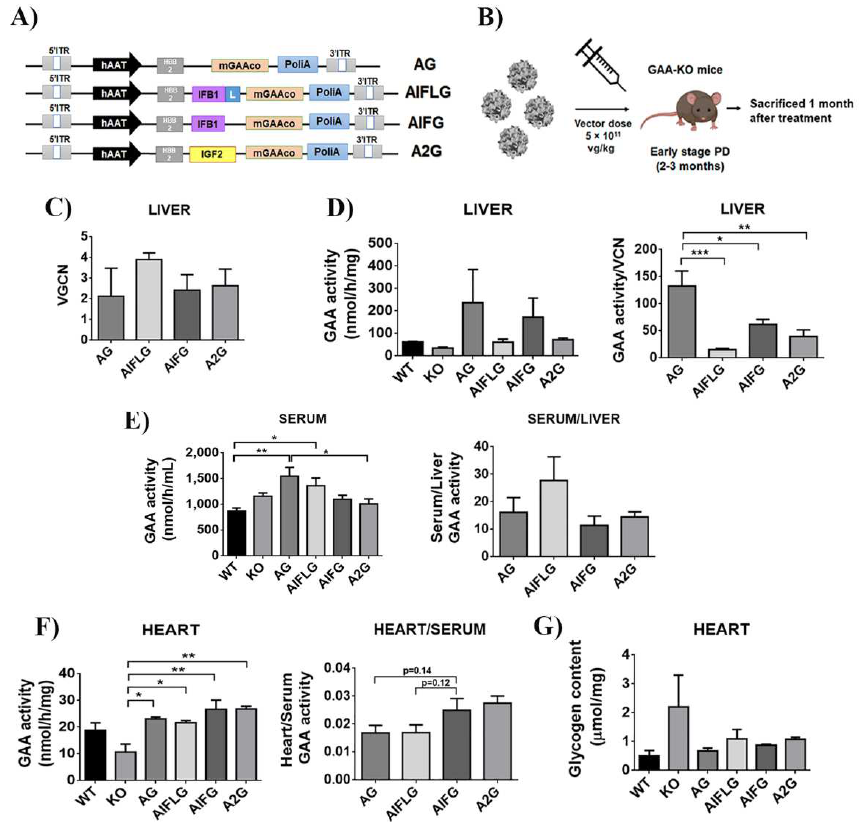
Figure 7. Comparison of the different GAA chimeras in GAA-KO mice. A ) Schematic representation of AG, AIFLG, AIFG and A2G AAV constructs. mGAA, murine glucosidase alpha acid; hAAT, human α1-antitrypsin promoter. B ) Workflow of in vivo experiment with AAV mGAA chimeras in GAA-KO mice. C ) Vector genome copy numbers (VGCN) found in the liver. D ) mGAA activity in the liver (left graph) and relative mGAA activity relativised by vector copy number (VGCN) in the liver (right graph). E ) mGAA activity in the serum (left graph) and relative levels of serum versus liver mGAA activity (right graph). F ) mGAA activity in the heart (left graph) and relative levels of heart versus serum mGAA activity (right graph). G ) Glycogen content in the heart. Statistical anal- yses: one-way ANOVA Tukey’s multiple comparison (* p <0.05, ** p < 0.01, *** p < 0.001). Values represent means +/- SEM of at least 4 treated mice of each group.